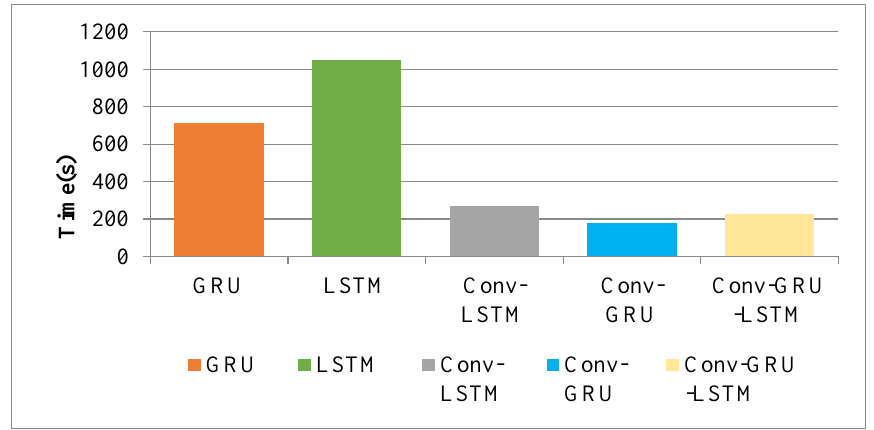
Figure 6. Average training time of each epoch.